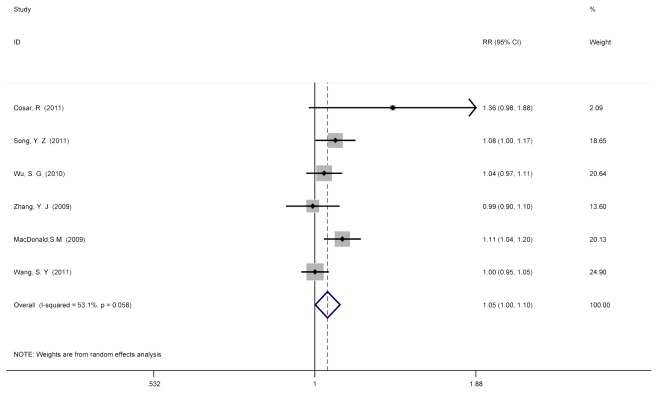
No PMRT versus PMRT after mastectomy surgery for T1/T2, N1-3+ patients on OS.To investigate the role of PMRT in T1/T2, N1-3+ patients on OS, analysis was conducted using available information from 6 of the 10 studies[11,17,18,20,22,24]. Random-effect model was chosen to estimate the RRs after pooled in view of the detected heterogeneity among these studies (Cochran’s p = 0.058; I2 = 53.1%), and the overall pooled RR of OS in patients with PMRT versus no-PMRT from the 6 trails was 1.051 (95% CI =1.001 to 1.104).